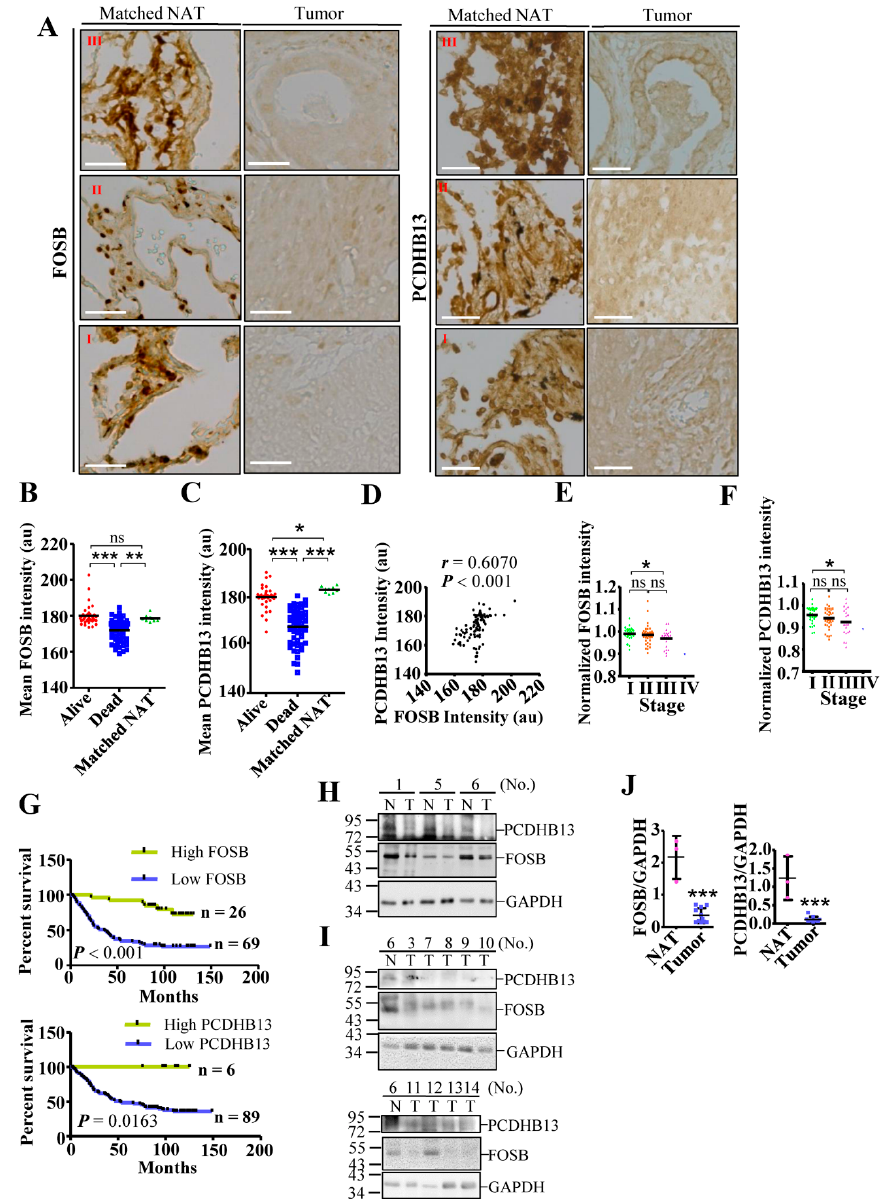
Figure 7. Downregulation of FOSB and PCDHB13 in lung cancer patients. ( A ) Matched NAT ( n = 9) and lung cancer samples ( n = 31, 42, 21, and 1 for grade I, II, III, and IV samples, respectively) were stained with DAB signal enhancement for FOSB and PCDHB13. Scale bar: 50 μ m. ( B,C ) Quantification of DAB staining intensity for FOSB ( B ) and PCDHB13 ( C ) in alive, dead, and matched NAT samples. ( D ) Correlation between FOSB and PCDHB13 levels in the alive group ( p < 0.001, Spearman’s r = 0.6070). ( E,F ) DAB staining intensity of FOSB ( E ) and PCDHB13 ( F ) were normalized to the respective values from matched NAT and were classified according to the disease stage. ( G ) Survival analysis of lung cancer patients according to relative FOSB expression (upper panel) and PCDHB13 expression (lower panel) level. Statistical comparisons of survival curves between groups were performed by Log-rank test. ** p < 0.001 for FOSB expression and * p < 0.05 for PCDHB13 expression. ( H , I ) Tissue extracts from twelve NSCLC patients were analyzed by Western blot using antibodies against FOSB, PCDHB13, and GAPDH. P: Lysates from EGFP/PCDHB13/FOSB-transfected A549 cells. N: normal adjacent tissue; T: tumor. ( J ) Quantitation of the FOSB and PCDHB13 levels shown in (H) and (I) ( n = 11). Quantitative results represent the mean ± SD (two-tailed t -test: ns, not significant; * p < 0.05; ** p < 0.01; *** p <